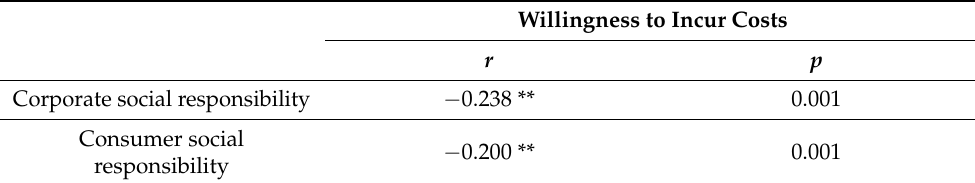
Table 5. Correlation coefficients between willingness to incur higher costs and negative evaluations of corporate and consumer social